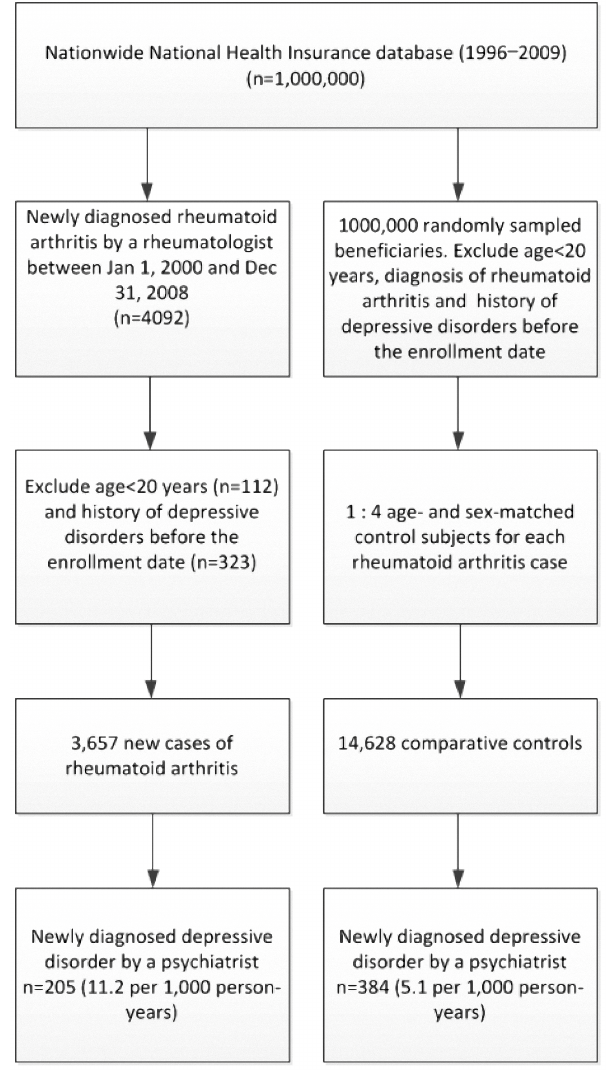
Figure 1. Flow chart of sample selection criteria.